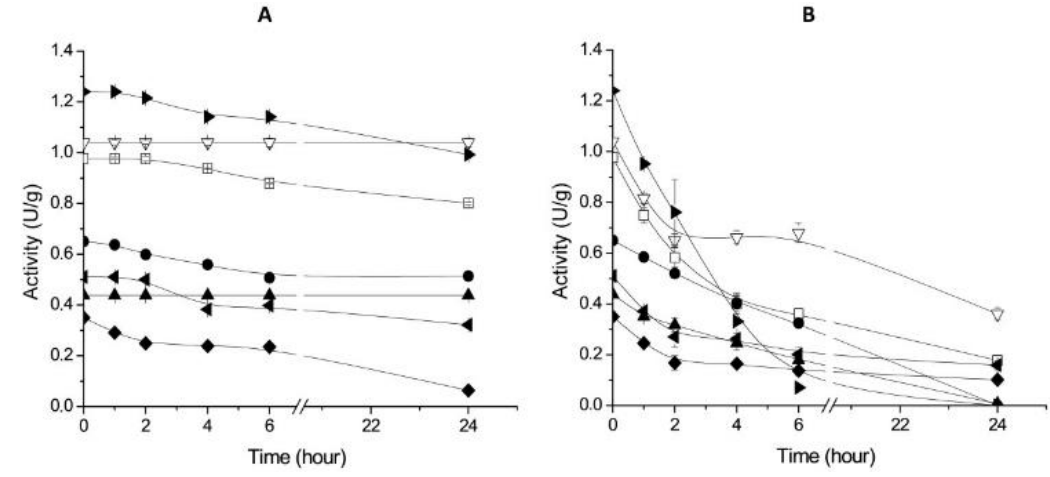
Figure 2. Thermal stability of F. verticillioides lipases ( A ) 40 °C ( B ) 50 °C. Symbols: -□- Butyl Sepharose; -●- Hexyl Toyopearl; - ▲ - Phenyl Toyopearl; - - Octyl Sepharose; - ► -Octadecyl Sepabeads - ◄ - CNBr-